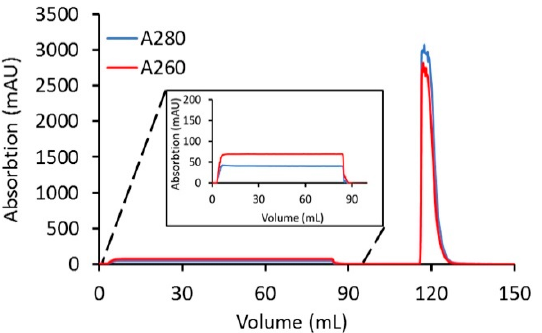
Figure 3. Clearance of linker-PBD from crude conjugation reaction mixture using the Sartobind ® S membrane. A total of 82 mg of cys-mAb-PBD crude reaction mixture (1 mg/mL) was loaded onto a 3 mL, 8 mm bed height Sartobind ® S membrane device at a flowrate of 1 MV/min. After loading the sample, the membrane was washed with 20 mM MES buffer at pH 6.0 for 10 MVs, and then the cys-mAb-PBD conjugate was eluted with 20 mM MES, 350 mM NaCl buffer, pH 6.0. The red line indicates the absorption at 260 nm; the blue line indicates the absorption at 280 nm.